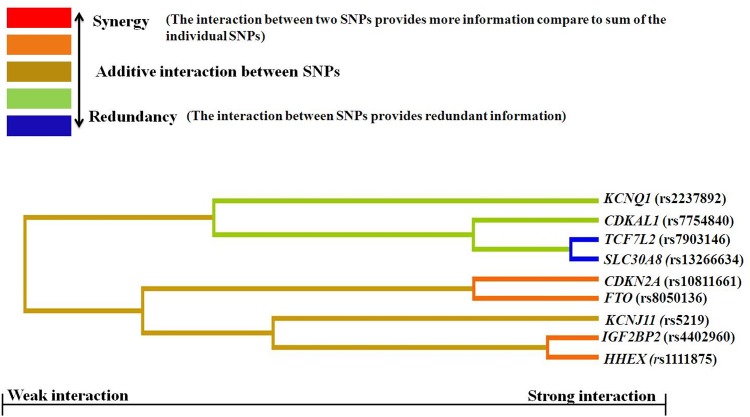
The dendrogram representing the nature of the interactions between SNPs.